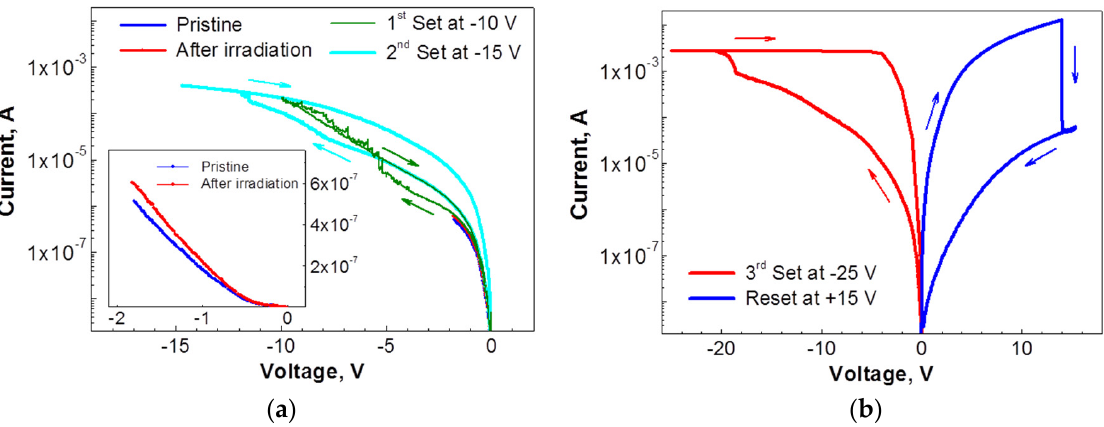
Figure 2. Current–voltage characteristics of Al/GO/n-Si MIS structures: ( a ) before and after e-beam irradiation of pristine device and after first and second Sets of negative voltage sweeps of up to − 10 V and − 15 V, respectively. Inset shows I–V characteristics of the pristine device and e-beam-irradiated device on linear scale; ( b ) after third Set voltage sweep of up to − 25 V, and subsequent Reset using voltage sweep of up to +15 V. Arrows show direction of the voltage sweep